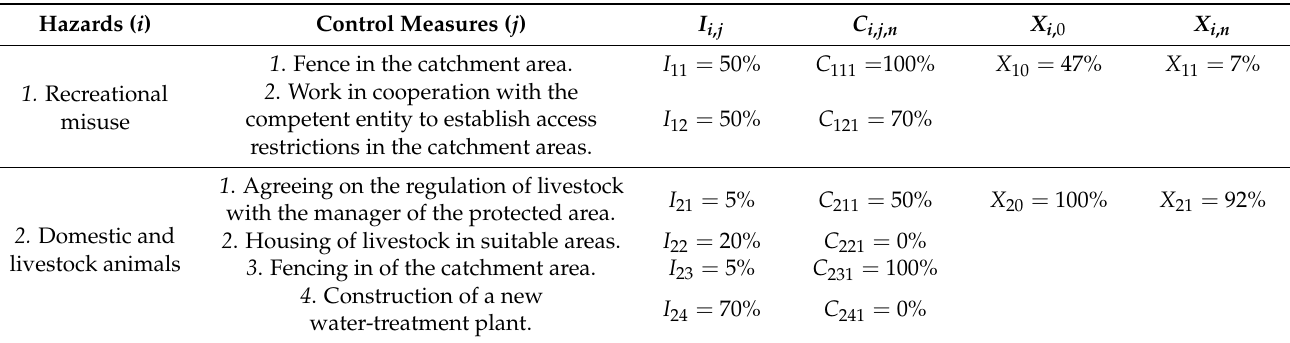
Table 3. Example of risk calculation for two hazards.